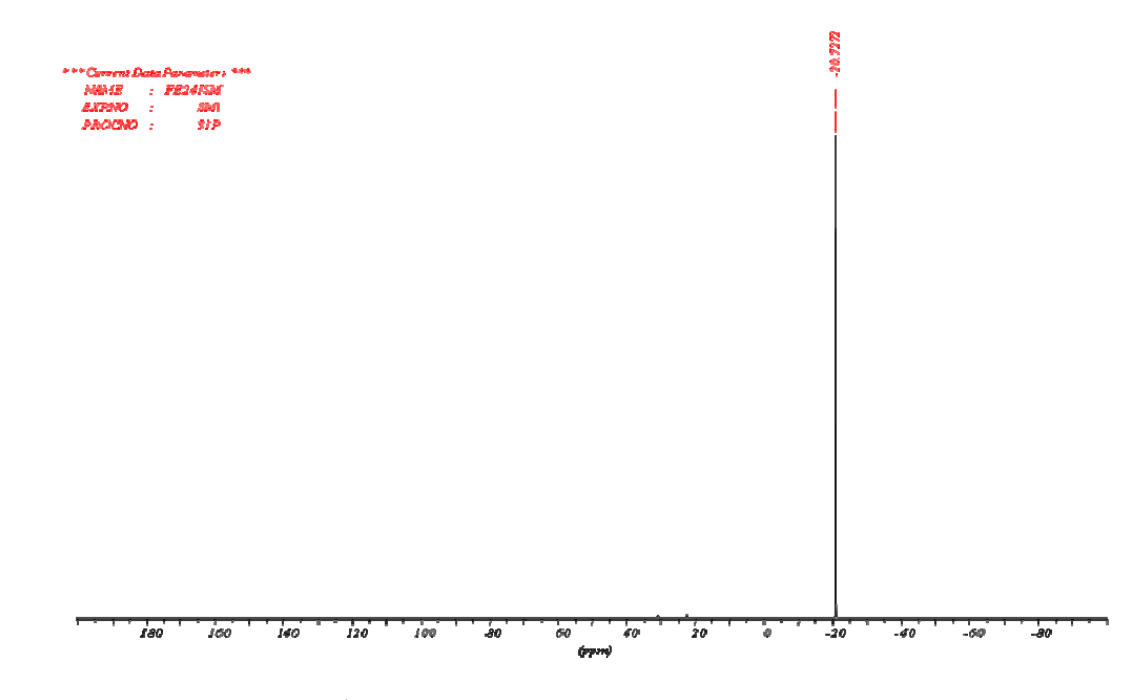
CH CH in CDCl 2 2 3